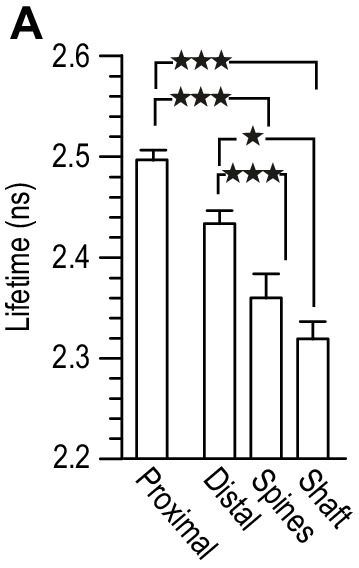
Lifetime measurement of GluN1-GFP co-transfected 14 div hippocampal neurons, with GluN1-mCherry, and Flag-GluN2B (1:3:2), at 10 div.Different regions were chosen in the fluorescent image: proximal (dendrite region close to the cellular body), distal (secondary dendrite region without NMDAR clusters), spines (NMDAR clusters with a spine-like morphology) and shaft (NMDAR clusters localized in dendrites). Comparison between the lifetimes within the different regions showed no difference between spines and shaft. All results in the main text are a result of a pull of spine and shaft NMDAR clusters. n = 40 proximal dendritic regions, n = 45 distal dendritic regions, n = 45 spine-like NMDAR clusters, n = 43 shaft-like NMDAR clusters. One-way analysis of variance; p<0.0001, followed by Bonferroni's multiple comparison test; *p<0.05, ***p<0.0001.